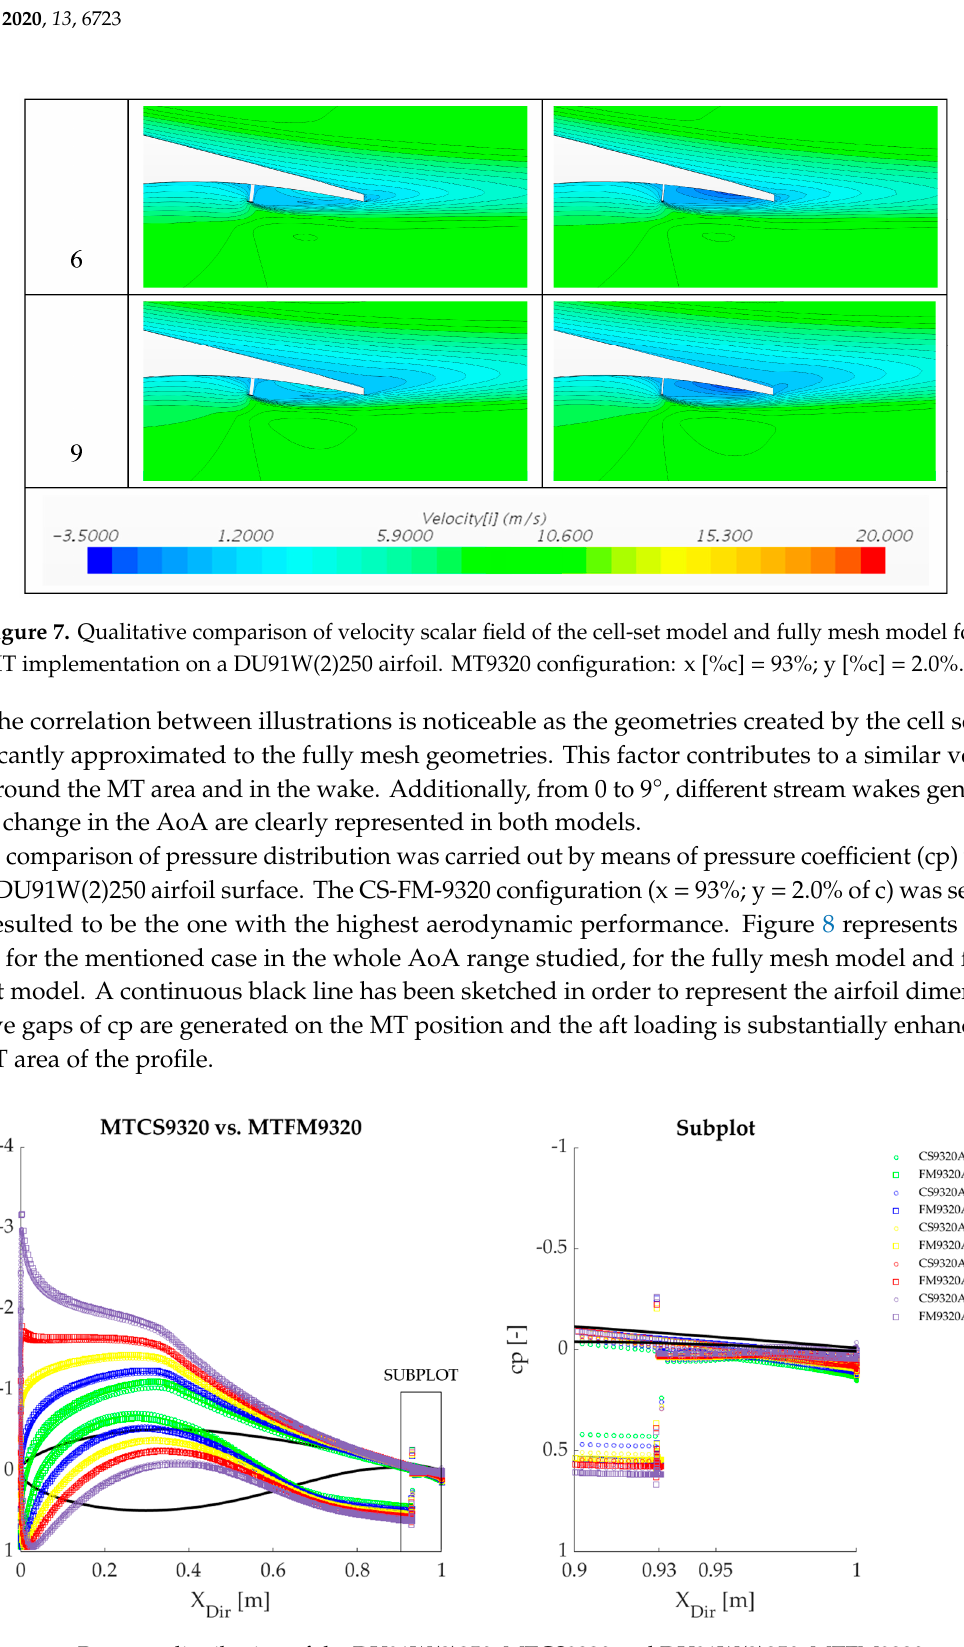
Figure 8. Pressure distribution of the DU91W(2)250_MTCS9320 and DU91W(2)250_MTFM9320 cases represented with the pressure coefficient (cp) at AoA = 0°, 2°, 4°, 6° and 9°. The subplot shows an enlarged view of the MT area.